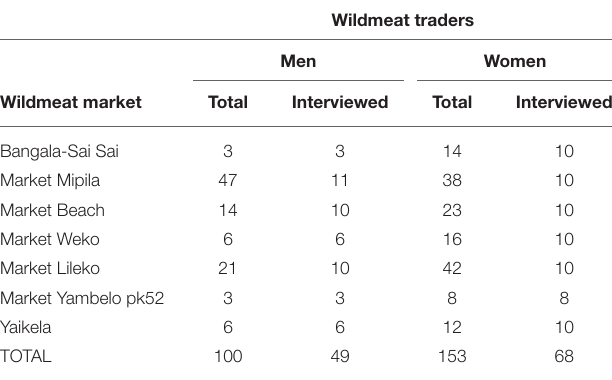
Wildmeat traders Men